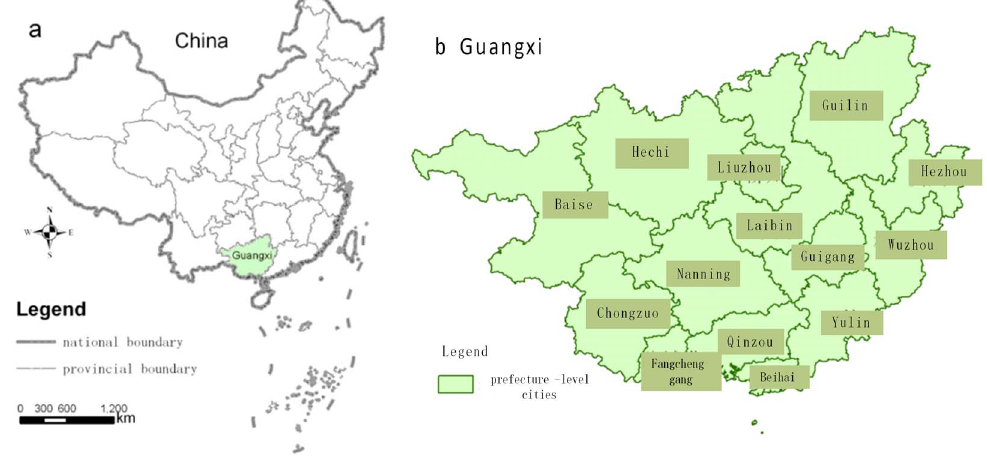
Figure 1. Administrative map of Guangxi Province.